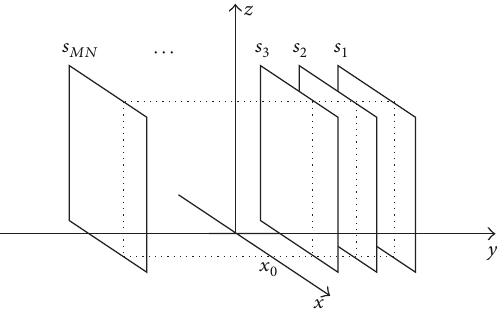
Figure 3: 2D focused images in cross track direction of down- looking sparse array SAR.